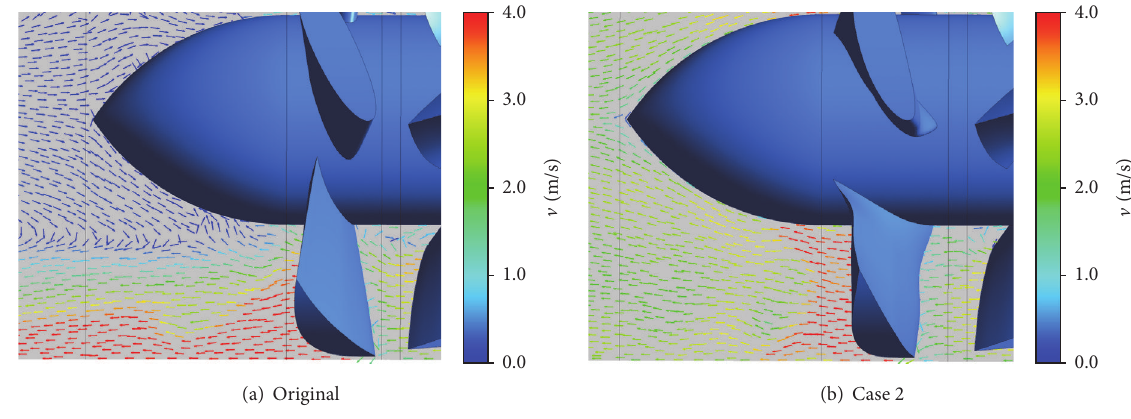
Figure 18: Absolute velocity vector ( 𝑛 = 2460 min −1 ,